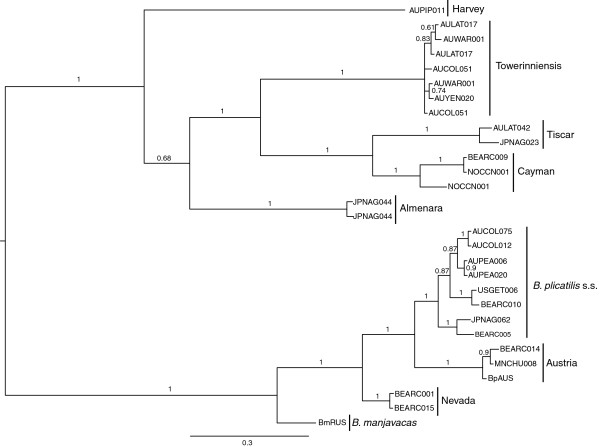
Bayesian trees of hsp82 coding sequences. Posterior probabilities are shown along the branches. Names at the tip of each branch designate isolates. Phylotype and major clade designations are shown to the right.